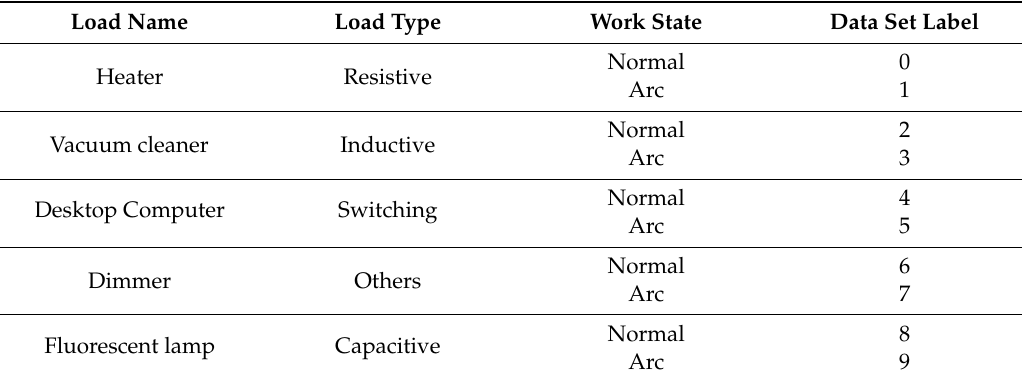
Figure 9. Visualization of the last layer with t-distribution stochastic neighbor embedding (t-SNE). ( a ) Initial stage of training; ( b ) late stage of training. Table 3. Typical loads and the corresponding